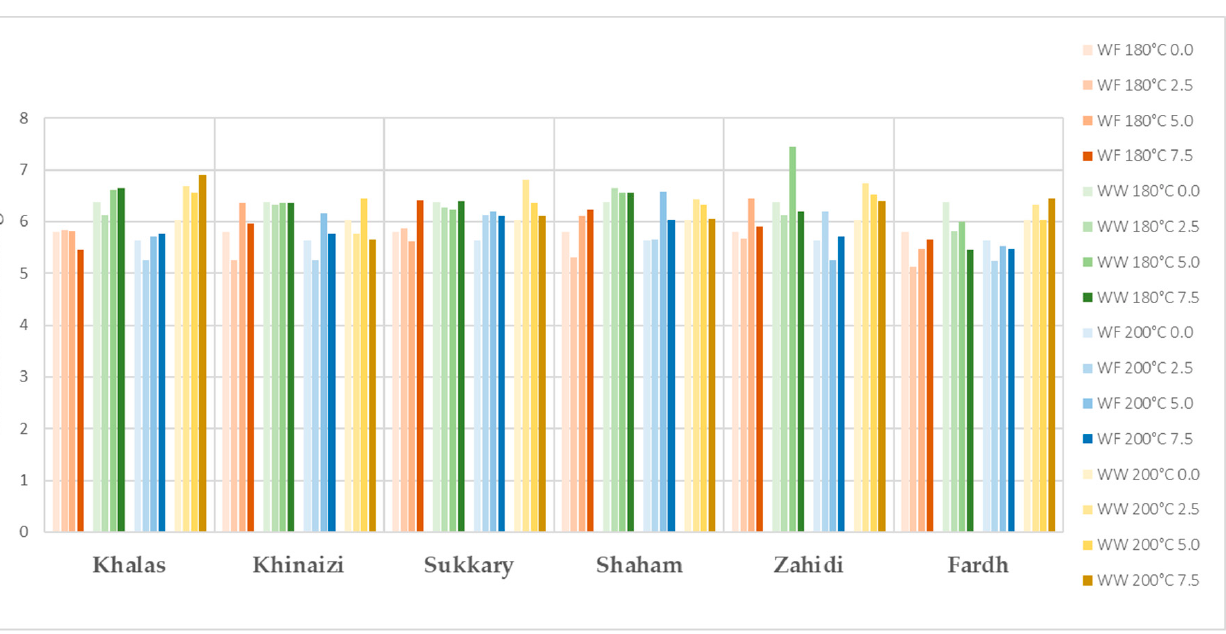
Figure 4. Taste evaluation for date seed composite cookies.